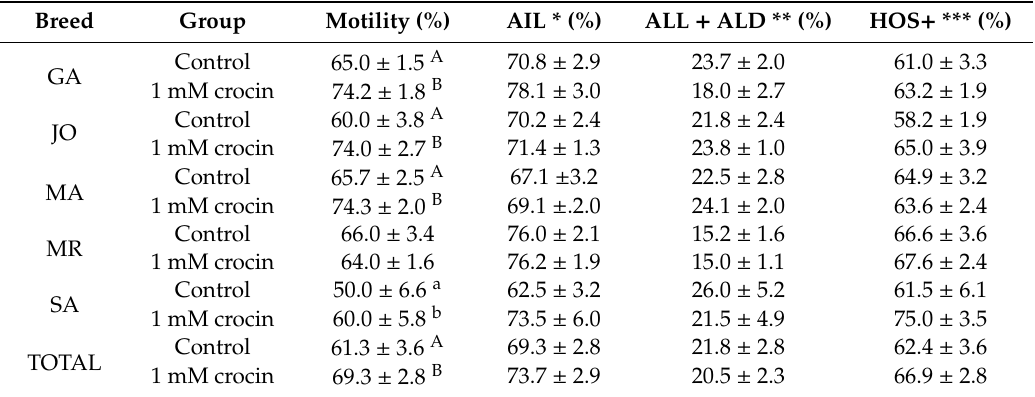
A,B Values within rows for each breed with different superscripts are different; p < 0.01. a,b Values within rows with different superscripts are different; p < 0.05. * AIL = acrosome intact live; ** ALL =